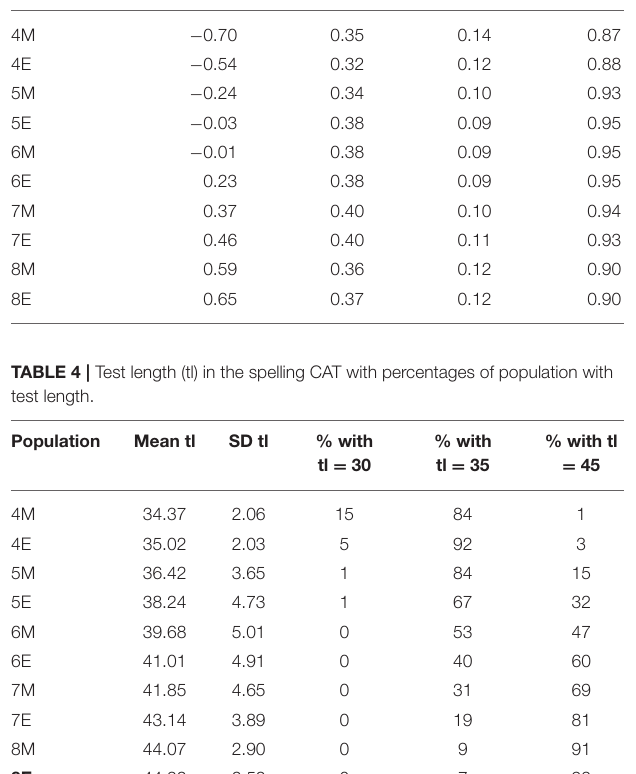
TABLE 3 | Measurement accuracy and reliability spelling CAT. Population